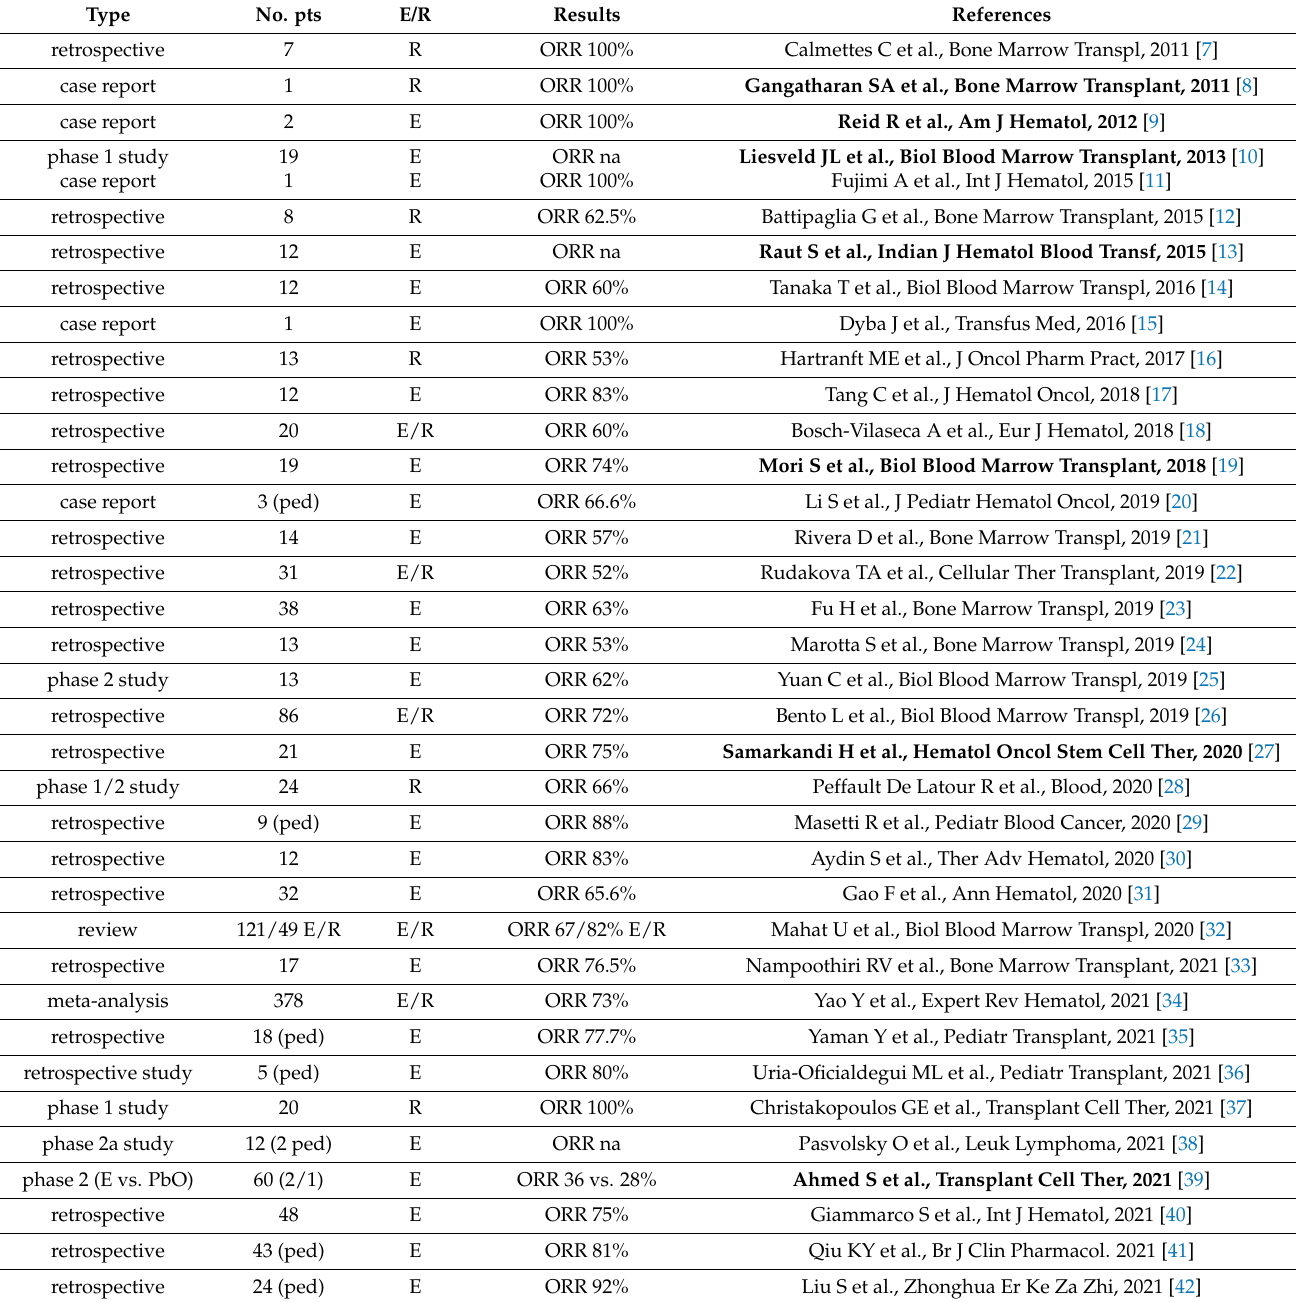
Table 1. Studies on TPO-RA